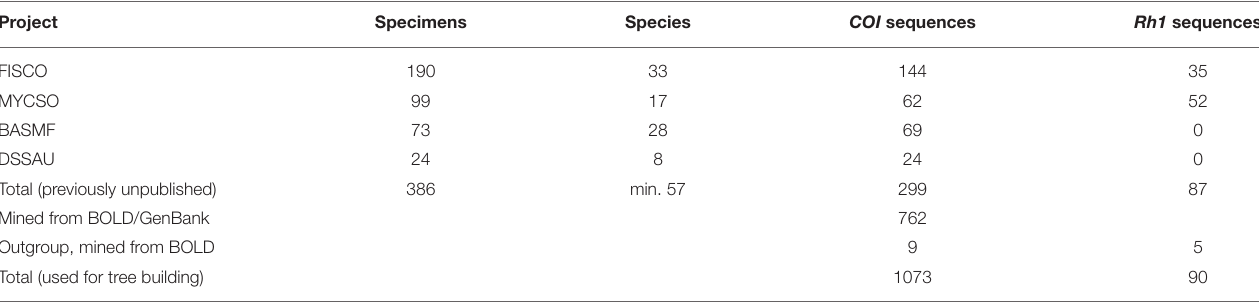
TABLE 1 | Overview of fish specimens and species and the respective numbers of DNA sequences that were successfully obtained for the cytochrome c oxidase I ( COI ) and rhodopsin ( rh1 ) gene.